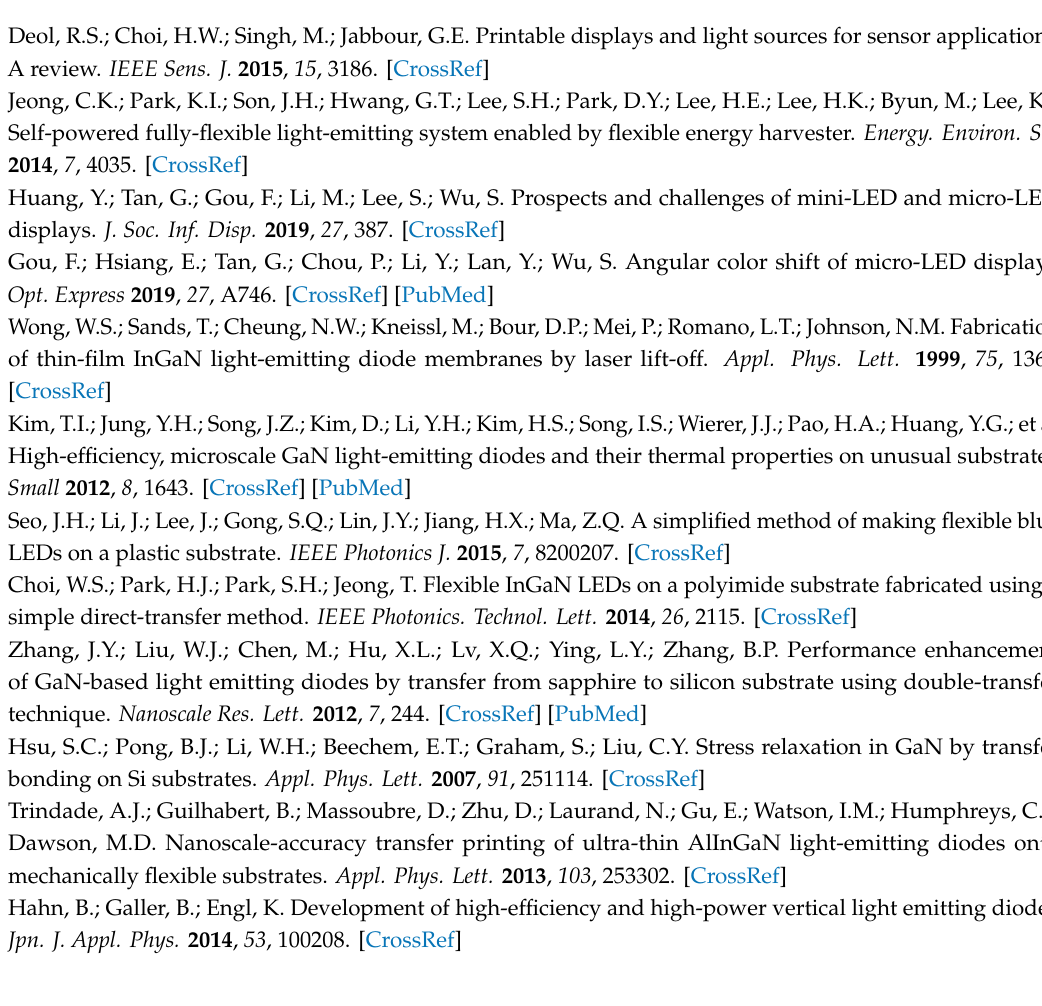
Figure S1: Spontaneous formation of vertical tethers. Figure S2: RSM of X-ray di ff raction intensity around the (105) reflector for micro LED ( a ) before and ( b ) after transfer to Si